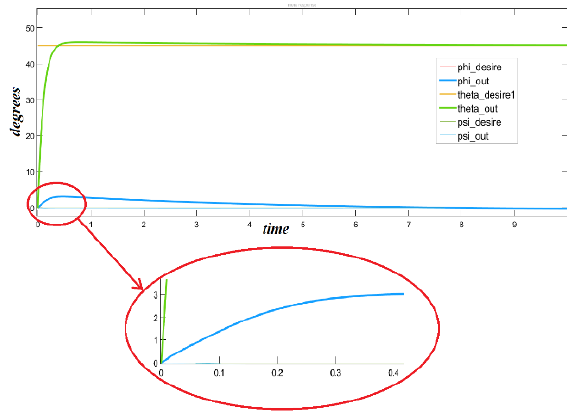
Figure 17.The predicted power consumption for the cross and